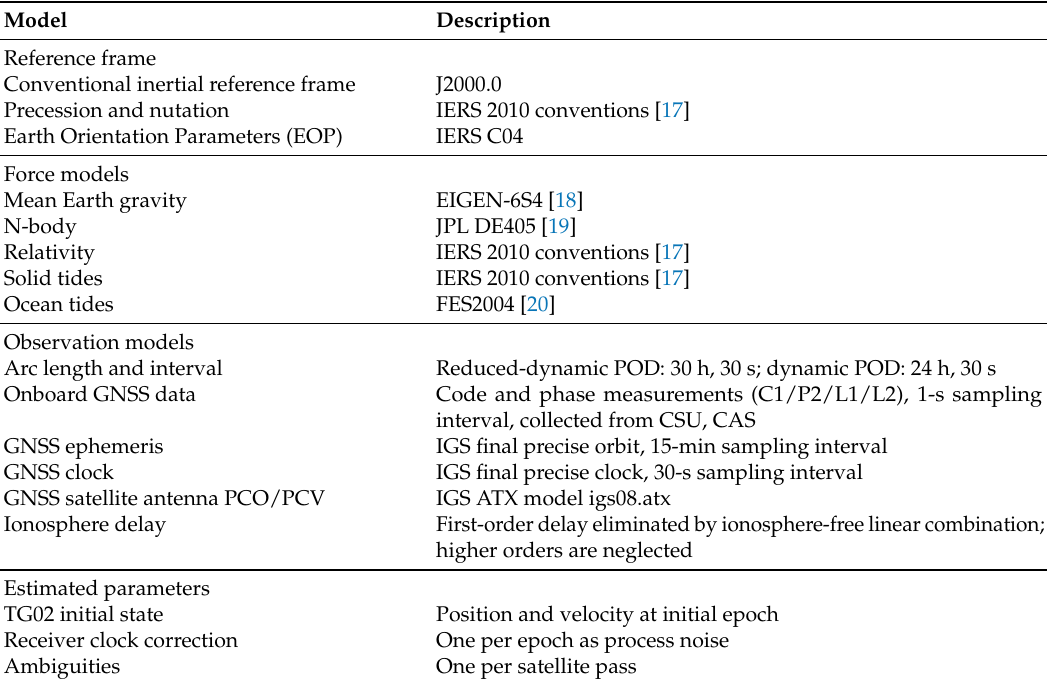
Table 1. GNSS-based TG02 POD